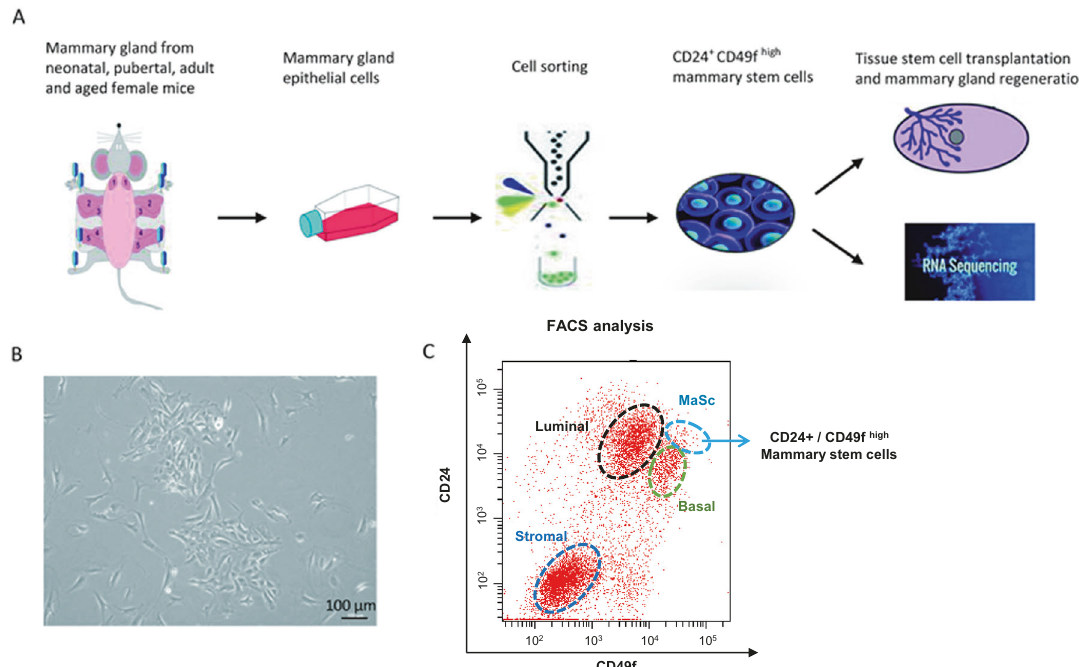
Fig. 1 Isolation of mammary gland stem cells from mice. A Schematic representation of the work fl ow to identify the evolution of gene expression signature in the mammary gland stem cells during development from neonatal to old mice. B Representative primary mammary epithelial cells isolated from the mammary gland of female mice. C The CD24 + CD49f high mammary stem cells were puri fi ed by cell sorting using fl ow